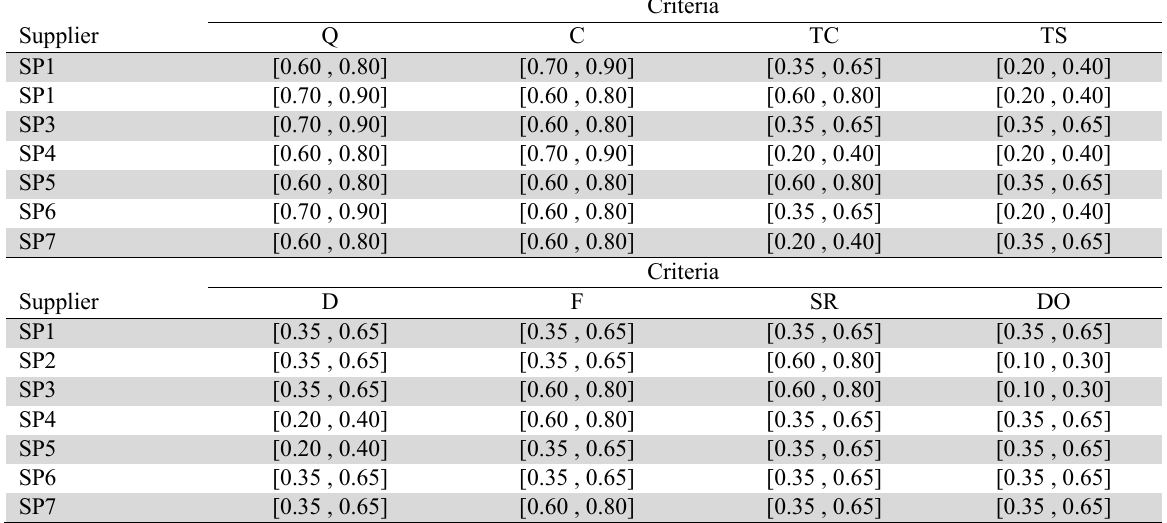
Grey Constructed Decision Matrix